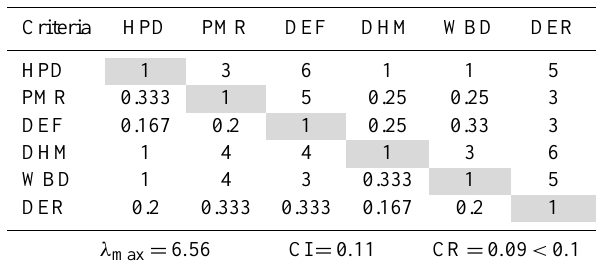
Table 3. Preference (pairwise comparison) matrix for group judgment.